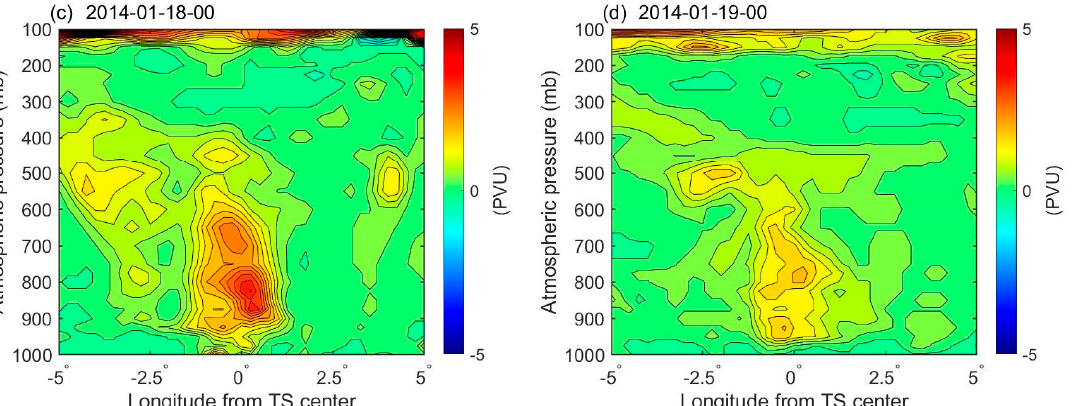
Figure 8. The change in the zonal vertical cross-section of the PV of ± 5 longitude over the TS center during TS development on ( a ) 00:00 UTC 16 January, ( b ) 00:00 UTC 17 January, ( c ) 00:00 UTC 18 January, ( d ) 00:00 UTC 19 January, (unit: PVU, 1PVU = 106 K m 2 kg − 1 s − 1 ).